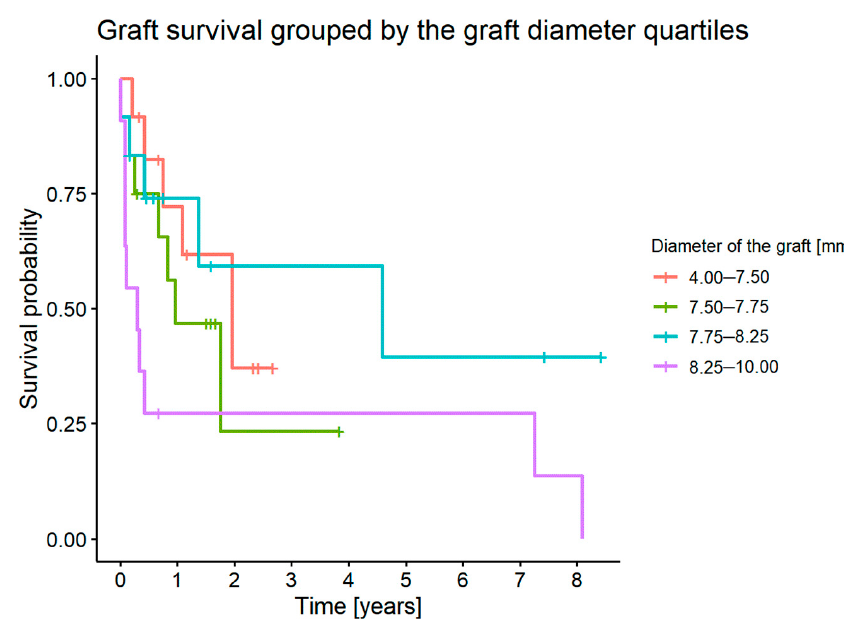
Figure 12. Graft survival grouped by the first graft diameter.